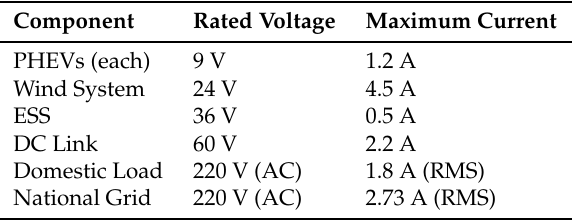
Table 5. Technical data for experimental setup.